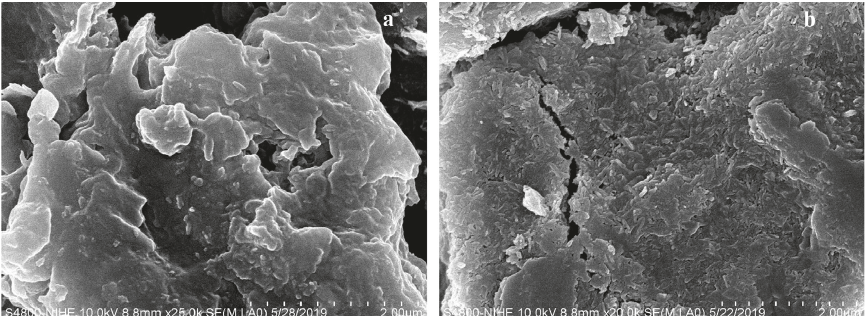
Figure 9: SEM images of PASGN.N catalysts before (a) and after (b) 500 scanning cycles in a (NaOH 0.5M+ C scan rate of 50mV · s − 1 .